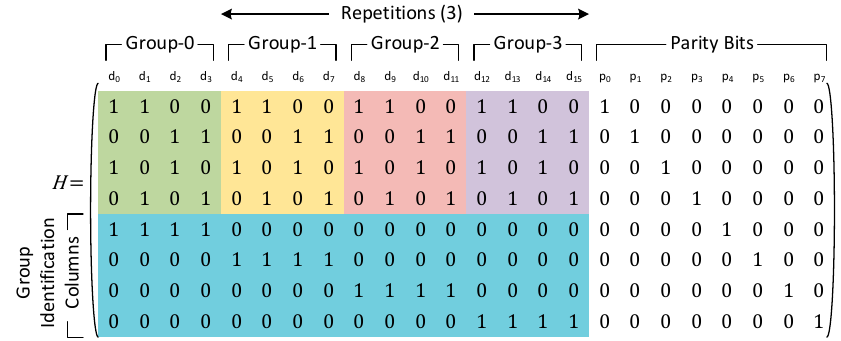
Figure 8. Parity check matrix for proposed latency optimization with four groups of four data bits